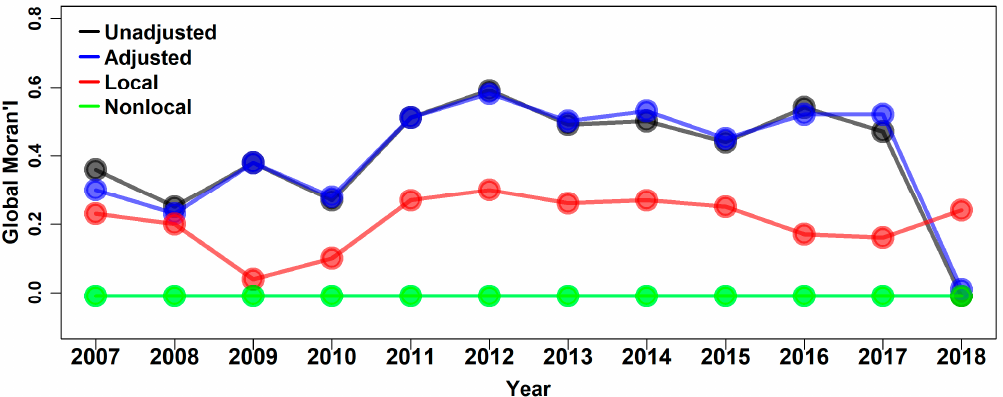
Figure 3. Annual Global Moran’I of different components from 2007 to 2018 in PRD. Lines in black, blue, red, and green are the original, meteorologically adjusted, local and nonlocal data, respectively.